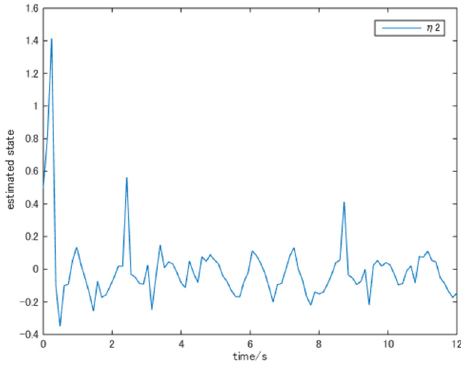
Figure 8. The trajectory of state